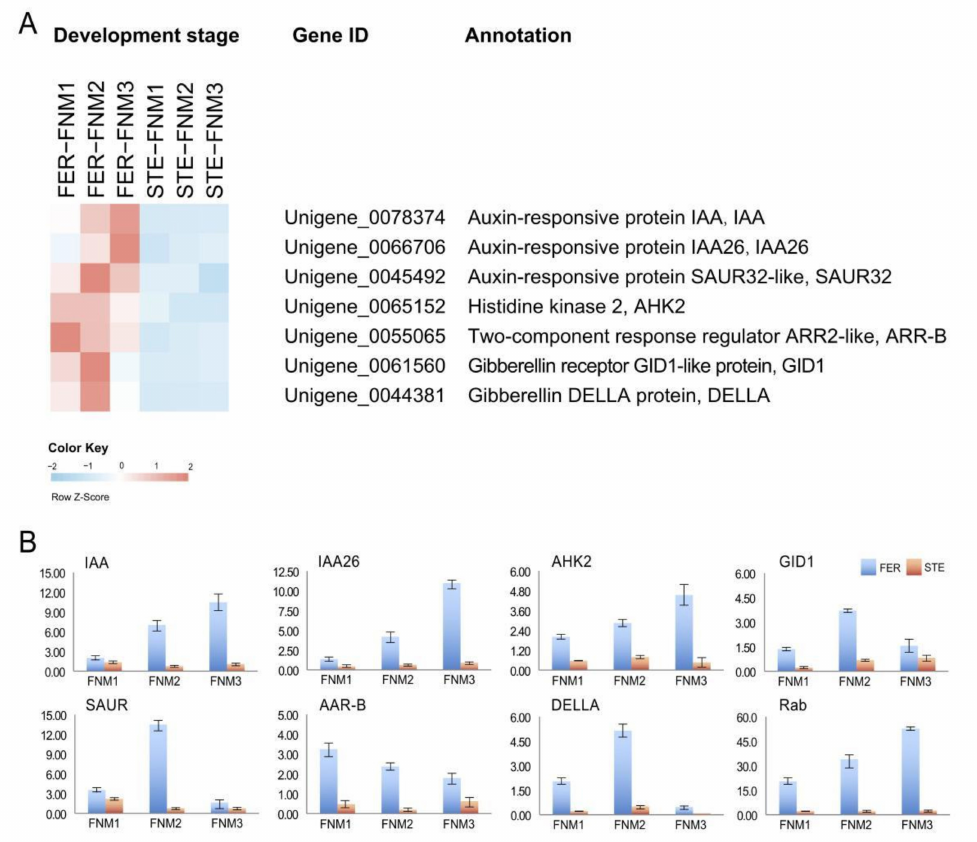
Figure 4. Analysis of expression levels of the differentially expressed genes. Expression patterns of differentially expressed genes related to the plant hormone. Data for the gene expression level were normalized to Z-score ( A ). Candidate DEGs expression levels revealed by qRT-PCR ( B ). Auxin- responsive protein IAA ( IAA ); auxin-responsive protein IAA26 ( IAA26 ); auxin-responsive protein SAUR32-like ( SAUR32 ); histidine kinase 2 ( AHK2 ); two-component response regulator ARR2-like ( ARR-B ); gibberellin receptor GID1-like protein ( GID1 ); gibberellin DELLA protein ( DELLA ); Rab-type small GTP-binding protein ( Rab